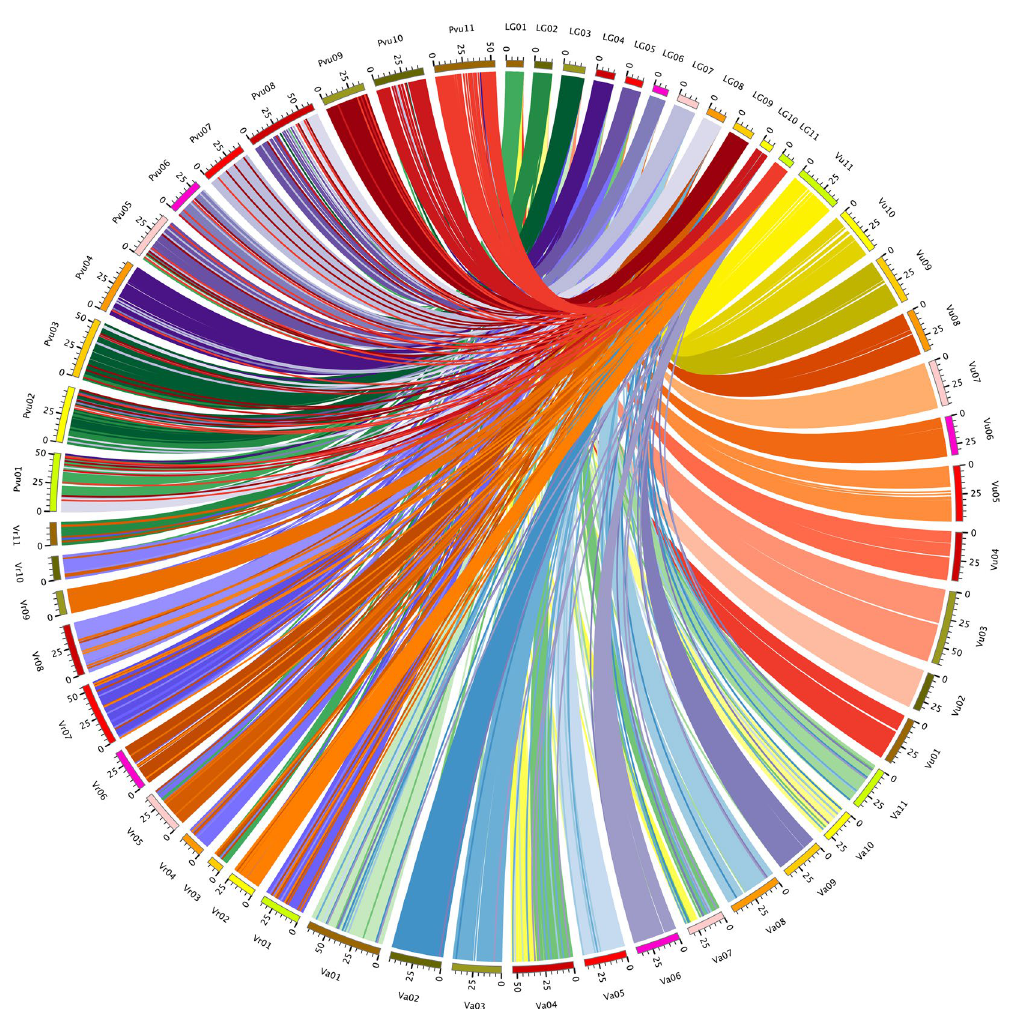
Figure 2. Circos map showing genome synteny between the genetic linkage map of Vigna vexillata (LG01–11) and the reference genome sequences of cowpea ( V . unguiculata ; Vu01–11), mungbean ( V . radiata ; Vr01–11), azuki bean ( V . angualaris ; Va01–11), and common bean ( Phaseolus vulgaris ;